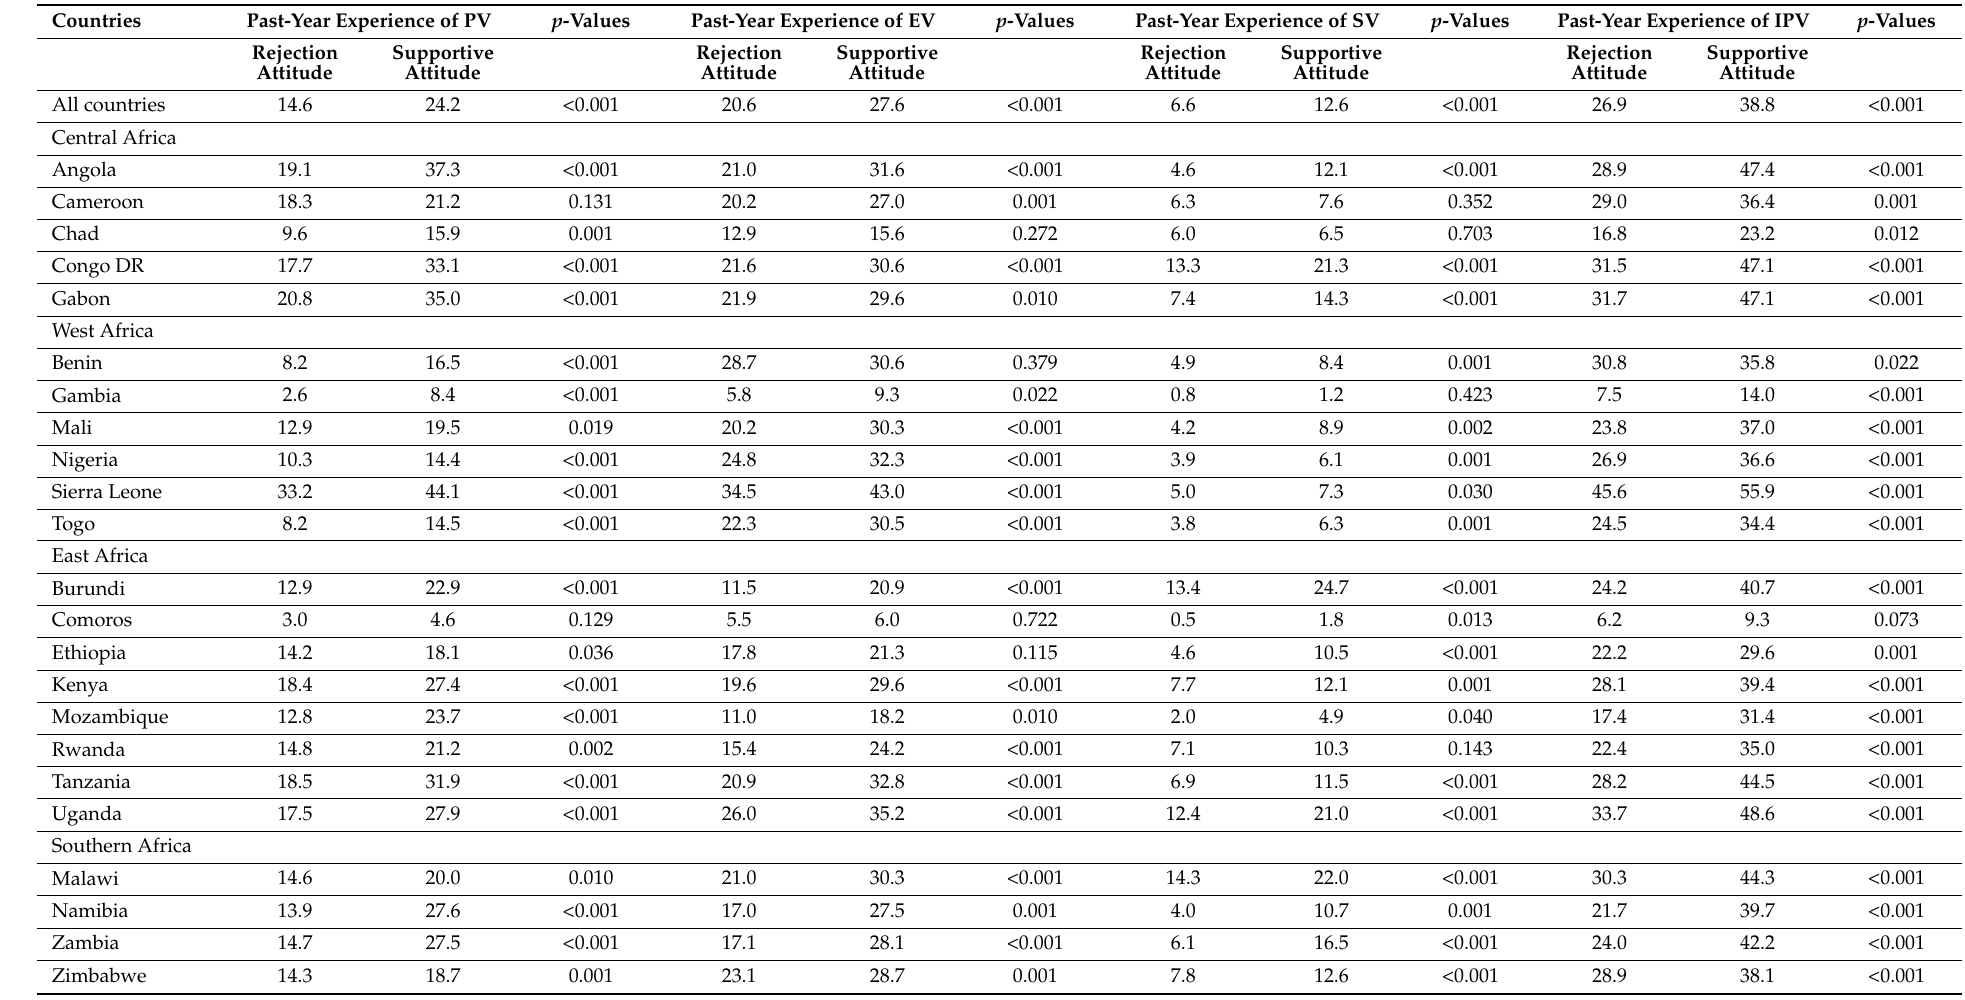
Table 2. Attitude towards IPV and past-year experience of IPV among women in sub-Saharan Africa by